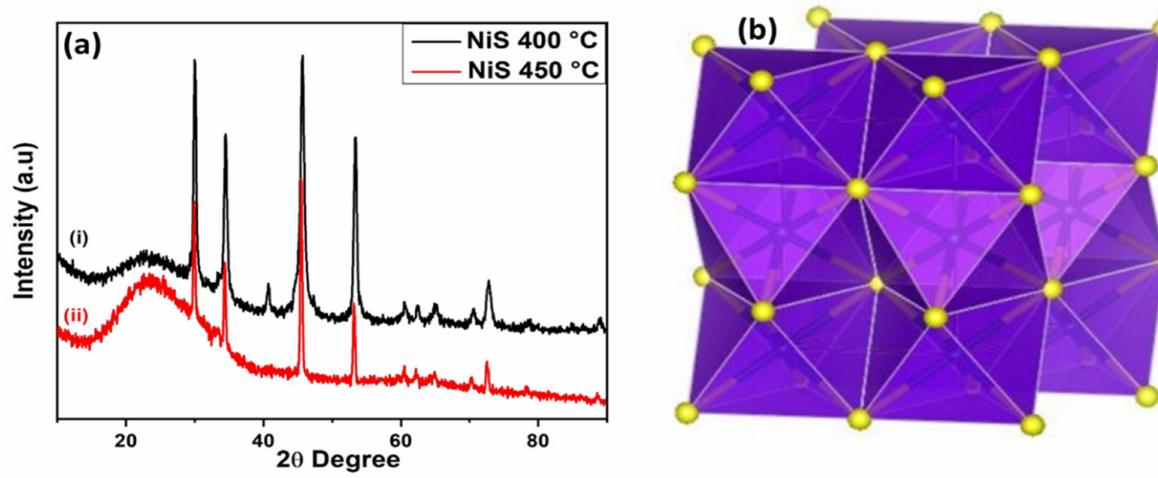
Figure 2. ( a ). XRD spectra of synthesized NiS at: (i) 400 ◦ C; (ii) 450 ◦ C ( b ) . Crystal structure of hexagonal NiS with yellow and blue spheres representing the sulfur and nickel atoms [36].